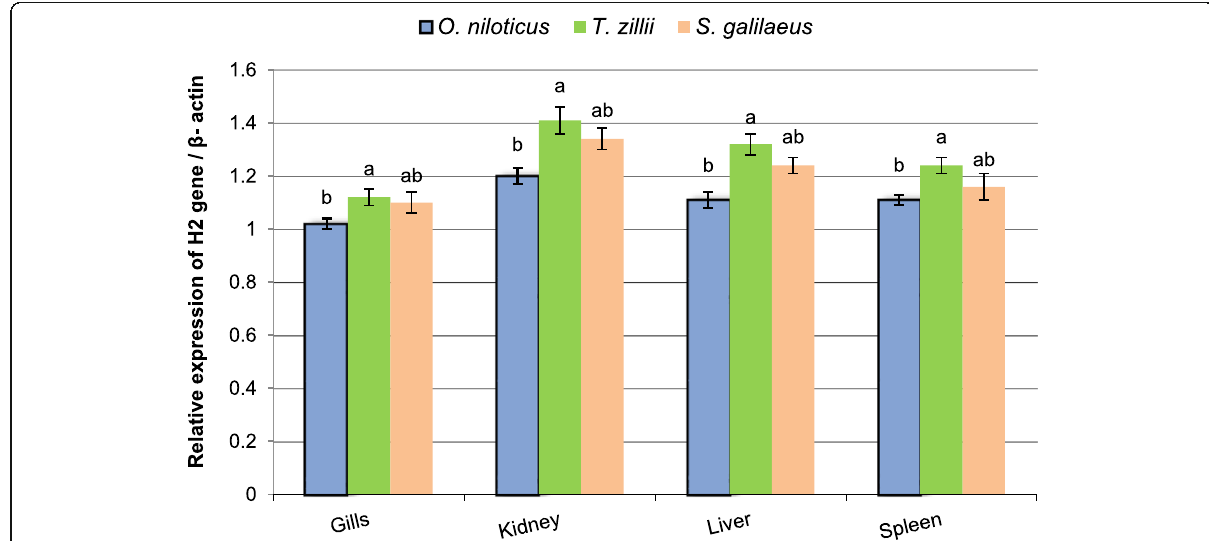
Fig. 13 Expression levels of some antimicrobial peptide gene hepcidin 2 (H2) in different tissues of O. niloticus , T. zillii and S. galilaeus . Data are presented as mean ± SEM. a,b followed by different superscripts are significantly different ( P ≤